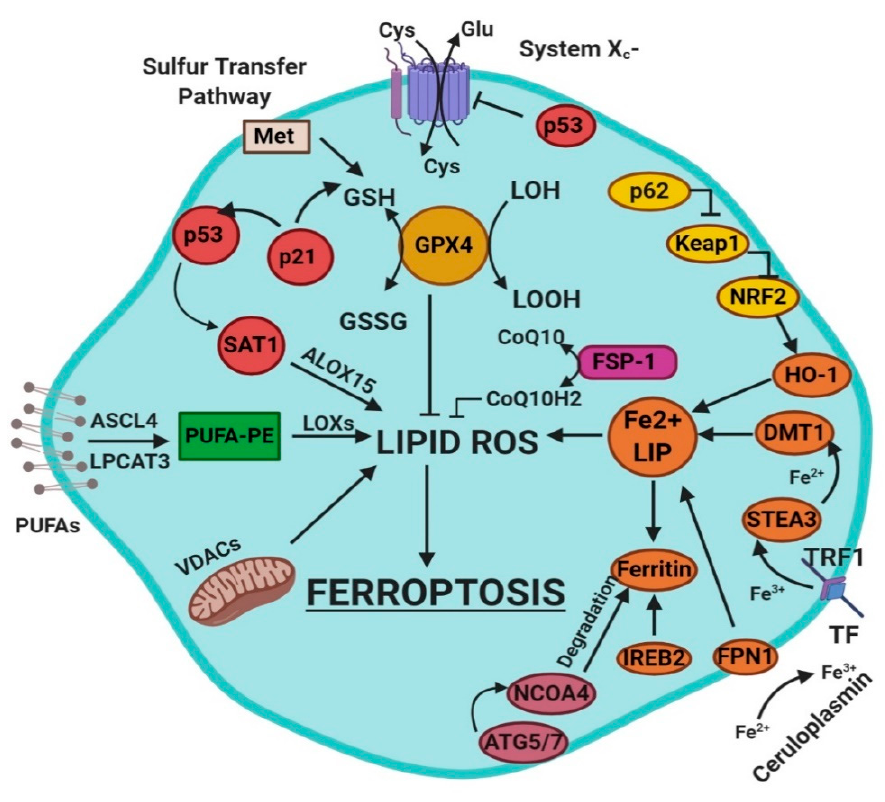
Figure 1. This figure summarizes the regulatory core of ferroptosis, approximately divided into three axes. The first axis is represented in the middle. It includes the GSH / GPX4, sulfur transfer and p53 pathways. The second axis (right part of theF) consists of the iron metabolism pathway, including IREB2 related to ferritin metabolism, the regulation of ATG5-ATG7-NCOA4 pathway and the p62-Keap1-Nrf2regulatorypathway. Theseelementscaninfluencetheconcentrationofintracellulariron, mandatory for the development of ferroptosis. On the left, the third axis implies that lipid metabolism p53-spermidine / spermine N1-acetyltransferase 1 (SAT1)-ALOX15, ACSL4, LPCAT3, etc. impact on fatty acids regulation and ferroptosis [3]. Finally, mitochondria are also involved, since VDACs (voltage-dependent anion channels) are inhibited by erastin. In parallel, the independent pathway ferroptosis suppressor protein 1-coenzyme Q10 (FSP-1-CoQ10) acts with GSH / GPX4 to contrast lipid peroxidation